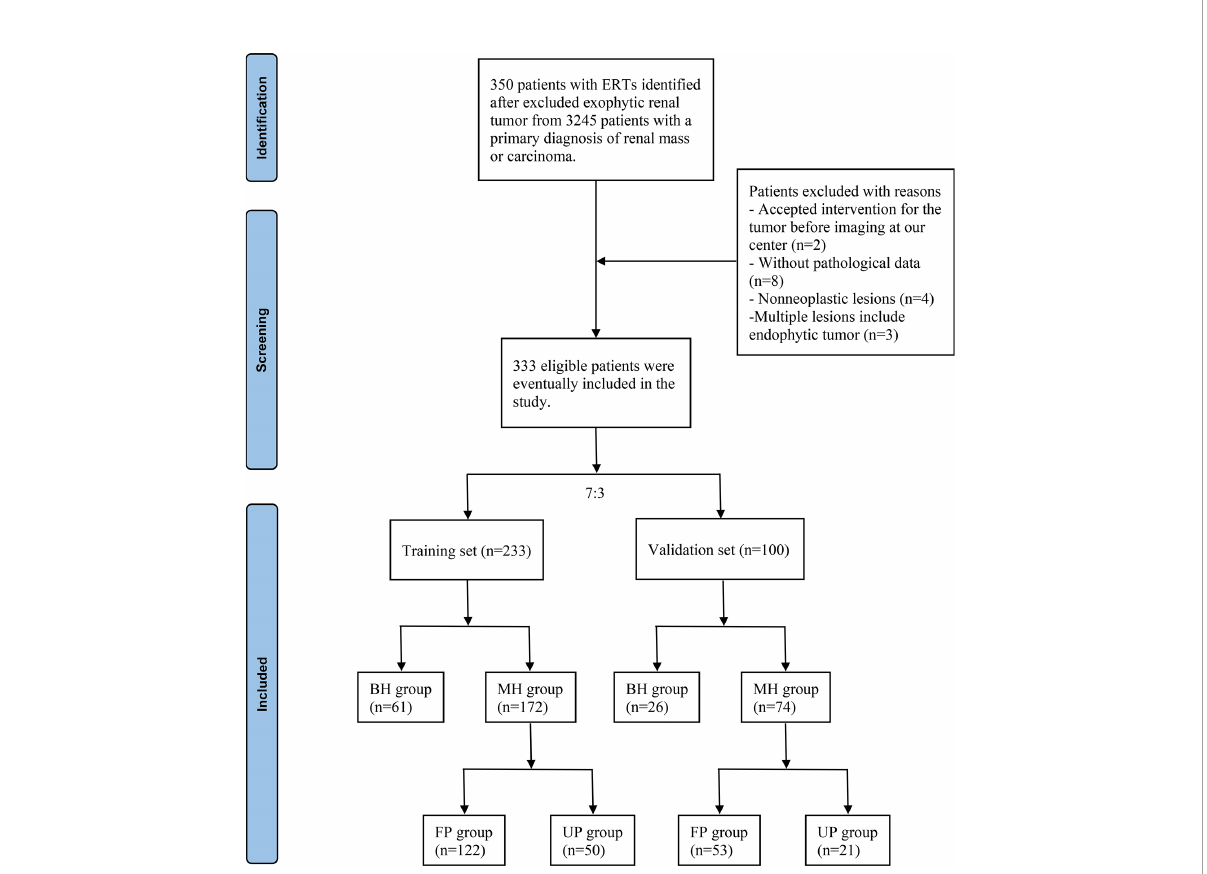
FIGURE 1 Flow chart of the included patients. ERTs, endophytic renal tumors; BH, benign histology; MH, malignant histology; FP, favorable pathology; UP, unfavorable